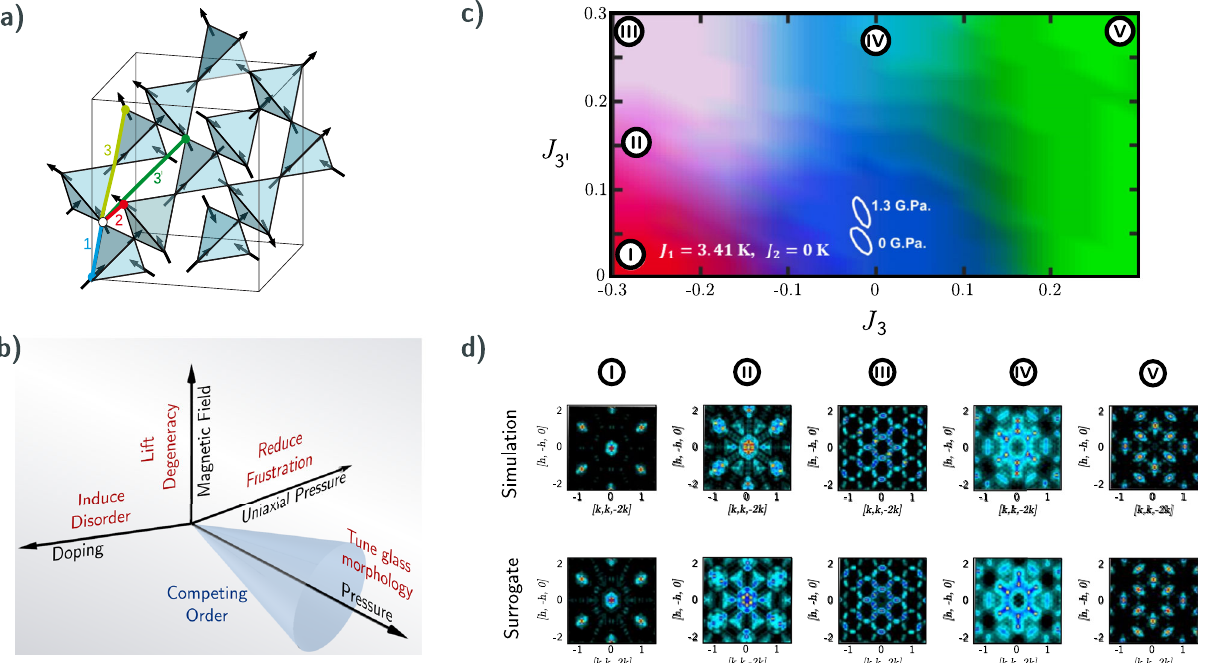
Fig. 2 Structure of the magnetic system, phase map and generative model. a In the frustrated material considered in this work, Dy 2 Ti 2 O 7 , the magnetic moments located on Dy ions are constrained by crystal fi eld interactions to point in or out of the tetrahedra. They form a corner sharing pyrochlore lattice. Nearest neighbors (1), next-nearest-neighbors (2) and two inequivalent next-next-nearest neighbors (3 and 3'); interactions are shown as thick colored lines. b Schematic diagram of the experimental parameters that can be used to tune the properties of frustrated materials and their associated effects. c A predicted map of magnetic orderings for varying J 3 and J 3 0 with the remaining Hamiltonian parameters J 1 , J 2 , and D fi xed to 3.41 K. 0 K and 1.3224 K respectively. The coordinates of a three-dimensional latent space predicted by a Generator network have been converted to an RGB color code. A region with uniform color is expected to be structurally the same, and continuous color changes correspond to either crossovers or continuous transitions. d Comparison between the high-symmetry-plane slices of simulated and surrogate-predicted S ( Q ) data at multiple places in parameter space (labelled from I to V) as indexed on panel ( c